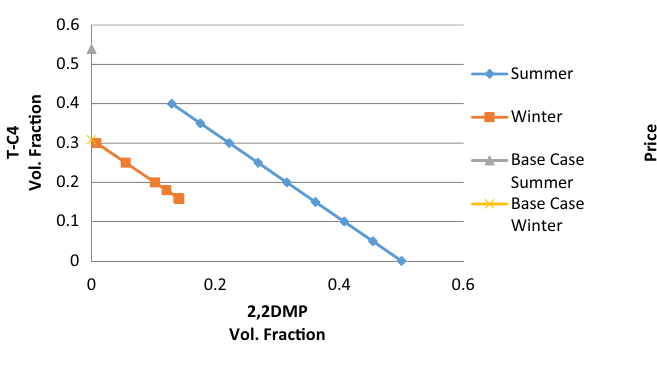
Fig. 16 Effect of adding 2,2DMP on LPG T-C4 content